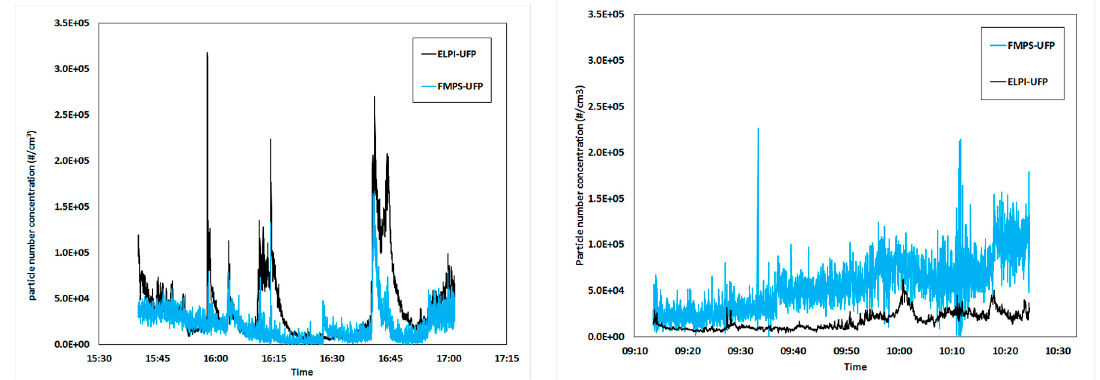
Figure 6. Ultrafine PM concentration as a function of collection time, as recorded by the ELPI and the FMPS during two different days of measurement. Results from day 1 are shown on the left, day 2 on the right.